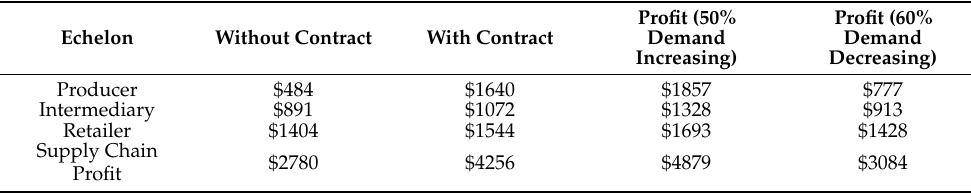
Table 5. Profit Behaviour with demand variation (Source: